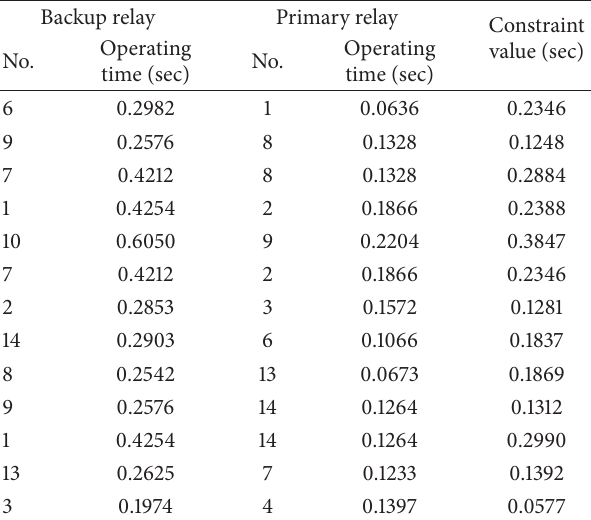
Table 7: 10 independent runs of a conventional PSO and the proposed NM-PSO in variable network